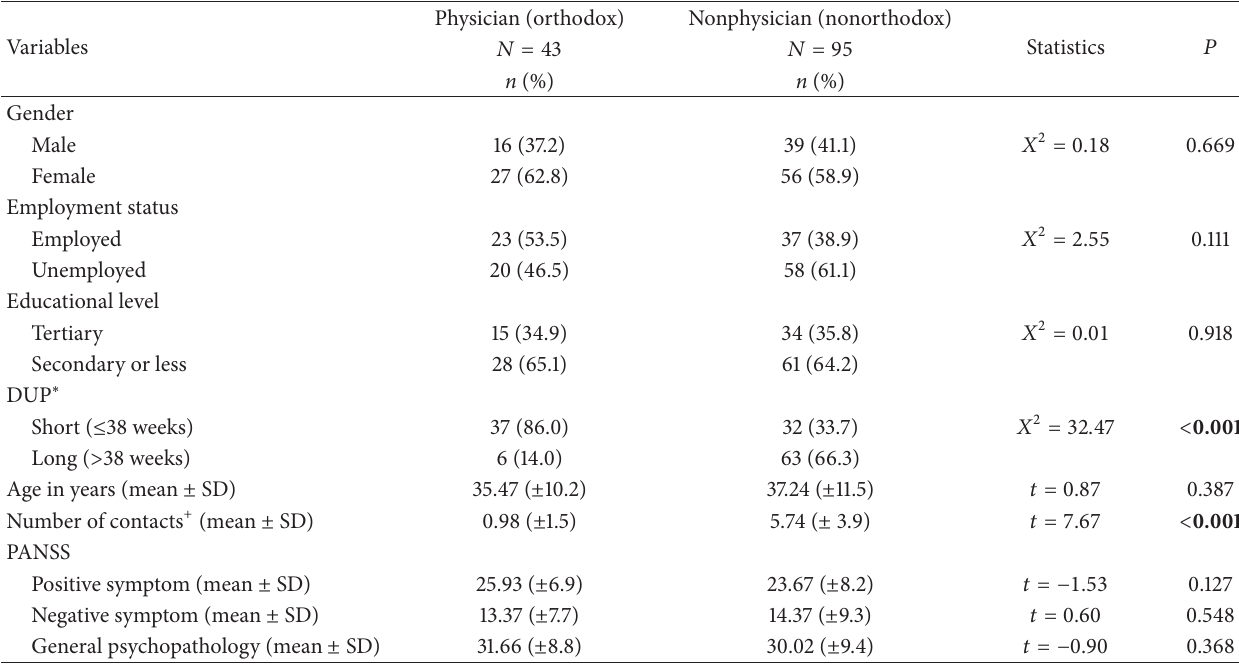
Table 3: Association between pathways to care and patients’ characteristics.